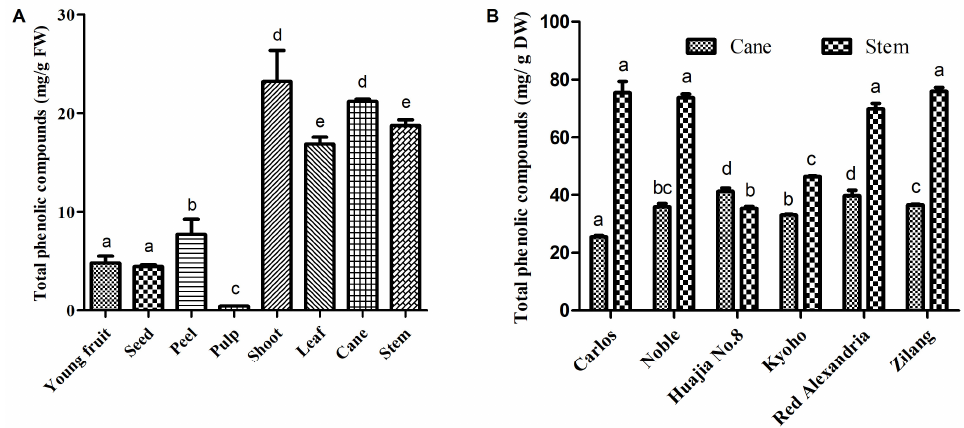
Figure 3. Total phenolic content in the different fresh tissues of V.davidii Foex ( A ), and the dried cane and stem extracts from different Vitis L. varieties ( B ). Bars with different letters are significantly different ( p < 0.05).